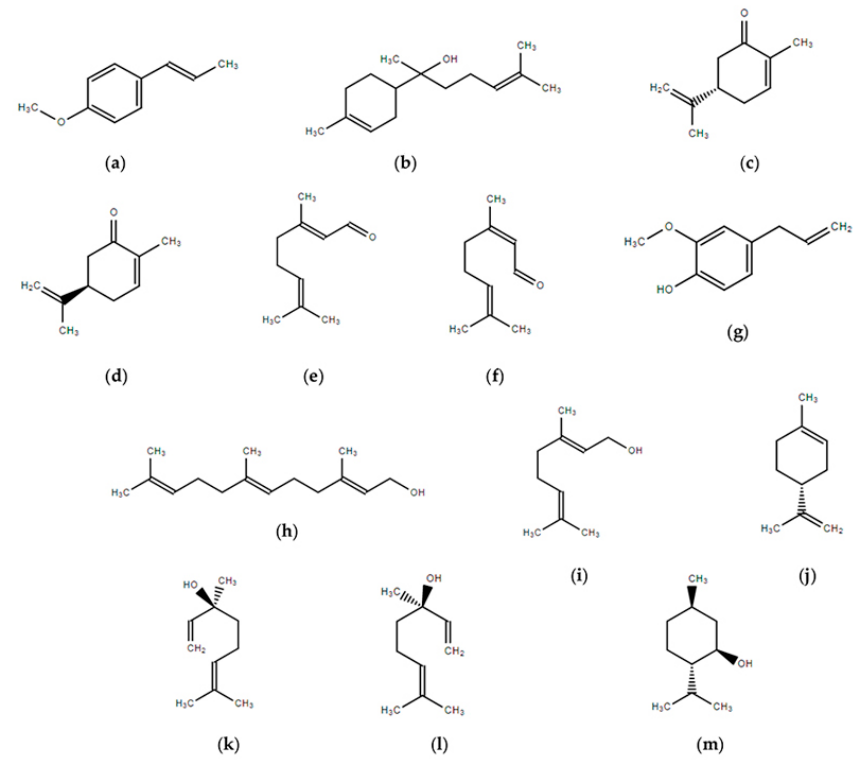
Figure 1. Chemical structures of most common fragrances. ( a ) trans Anethole; ( b ) α -Bisabolol; ( c ) S-(+)-Carvone (caraway); ( d ) R-(-)-Carvone (spearmint); ( e ) Geranial (citral A); ( f ) Neral (citral B); ( g ) Eugenol; ( h ) Farnesol; ( i ) Geraniol; ( j ) D -Limonene; ( k ) S-(+)-Linalool; ( l ) R-(-)-Linalool; ( m ) (-)-Menthol.